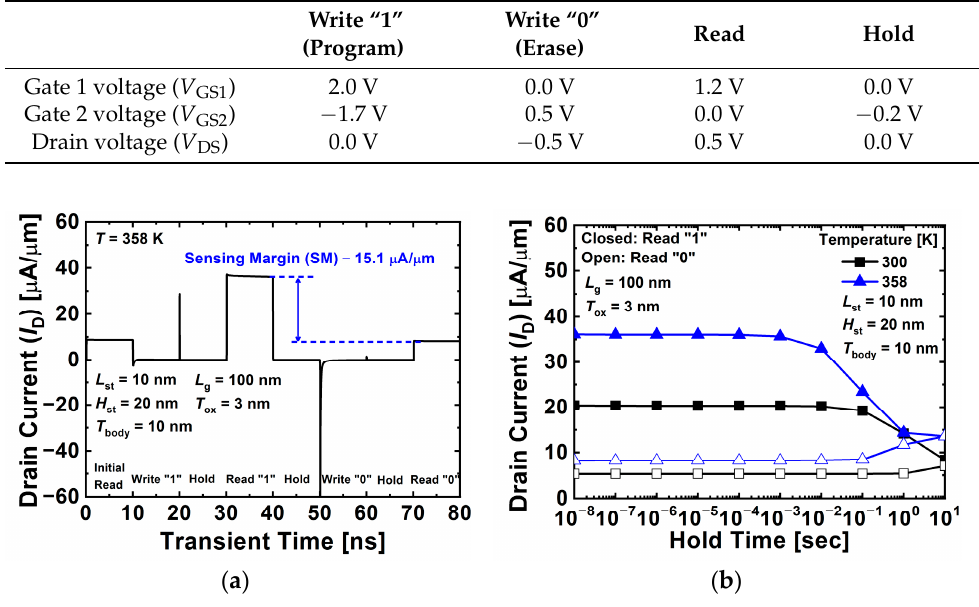
Figure 4. ( a ) Transient characteristics of proposed 1T-DRAM cell. ( b ) Variation of read currents in “1” and “0” states at different temperatures of 300 K and 358 K.